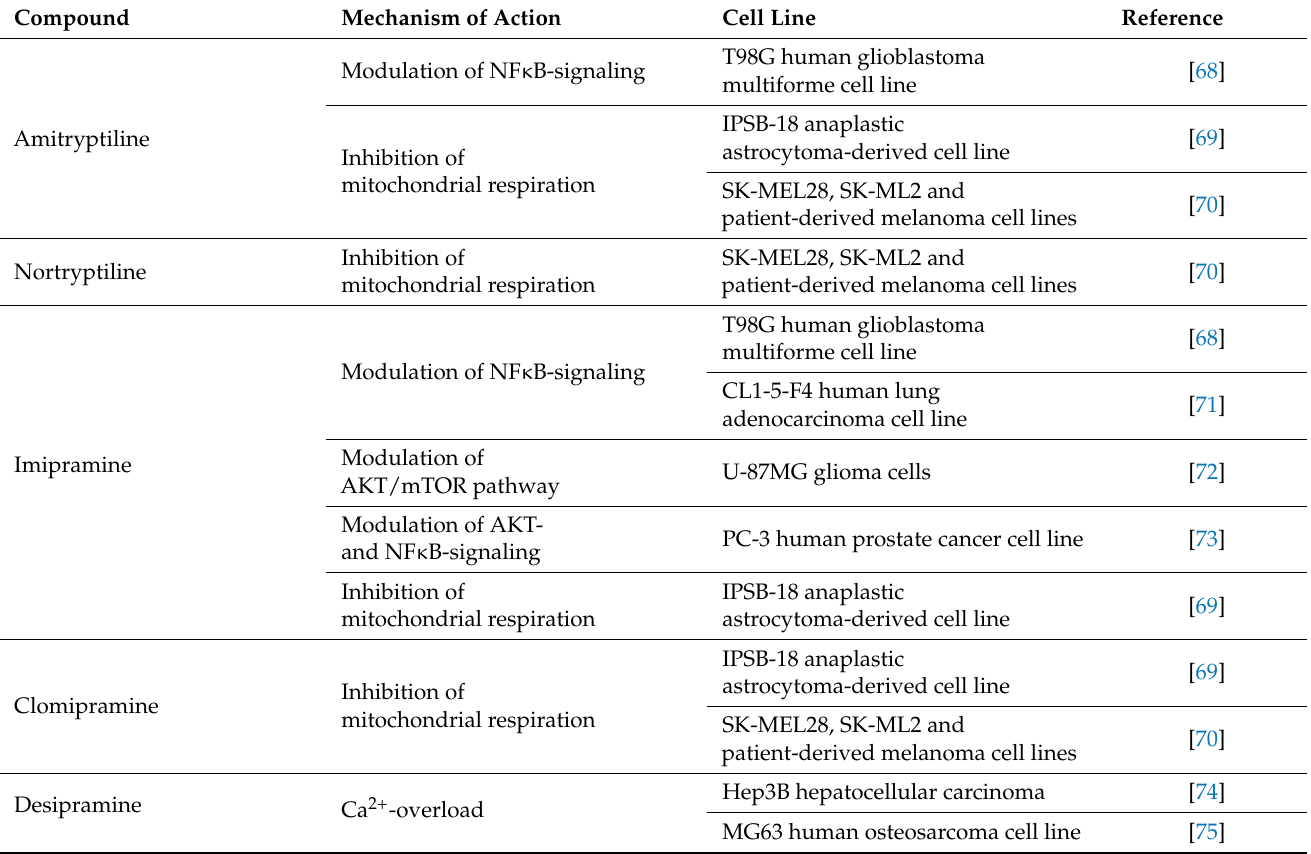
Table 2. Tricyclic antidepressants (TCAs) with anticancer